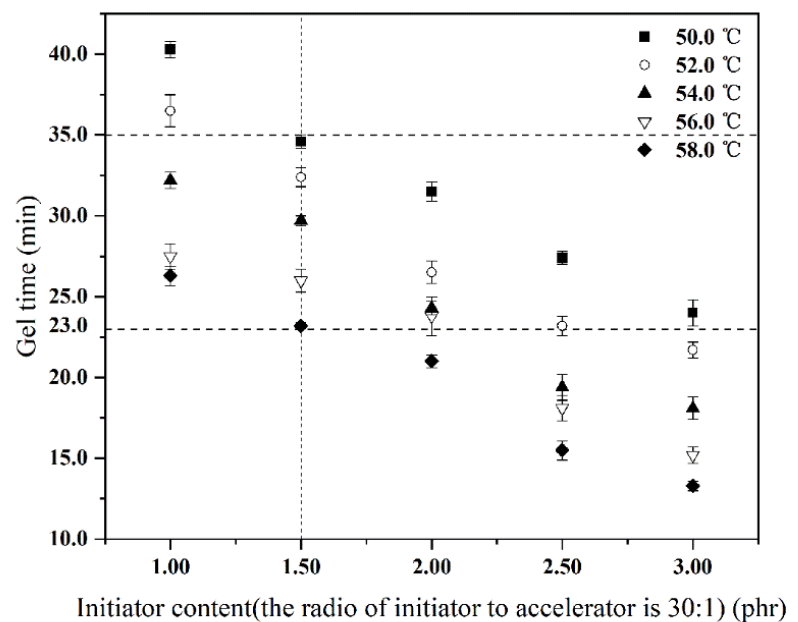
Figure 5. Gel time of resin glue with different contents of initiator MEKP-II and accelerator at temperature from 50.0 °C to 58.0 °C.